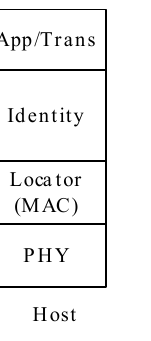
Figure 14. Protocol stack of host and connection with other entities.